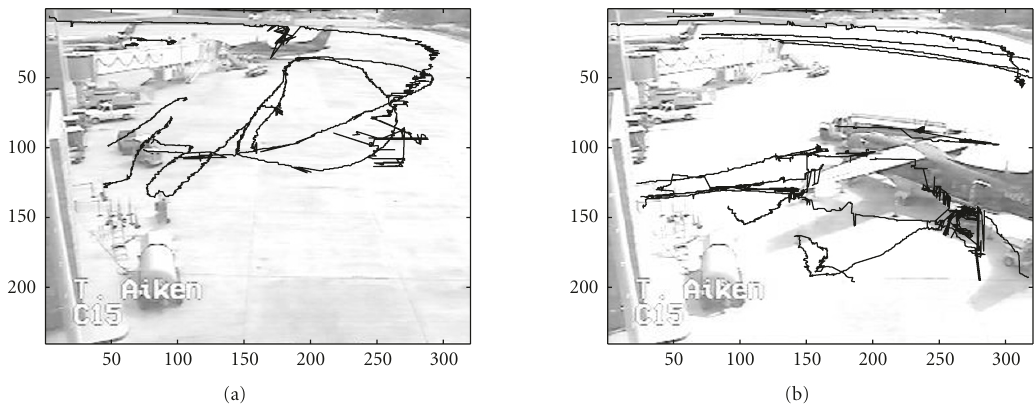
Figure 2: TSA airport tarmac surveillance dataset. Each image represents a block of 10000 frames along with motion trajectories extracted.